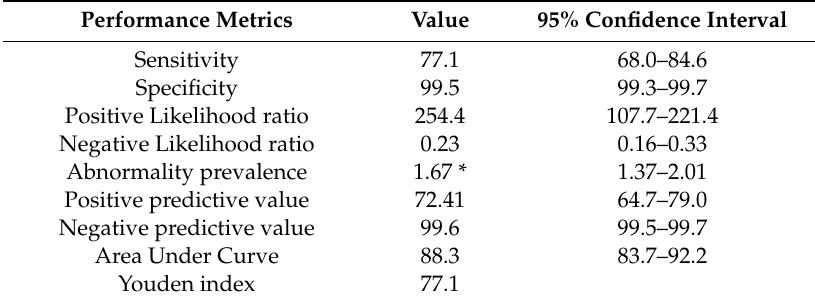
Table 2. Average diagnostic e ffi cacy across